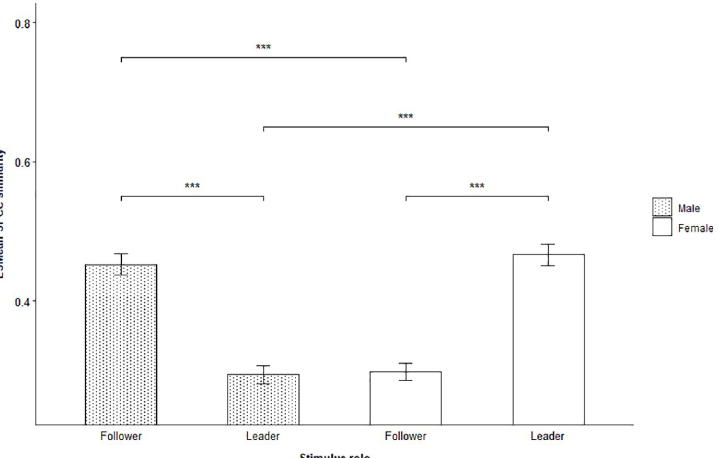
Fig 7. Effect of vocal role and sex on stimulus-response similarity. LSMean ( ± SE) spectrographic cross-correlation (SPCC) similarity between stimulus calls and focal flock responses emitted during the interaction phase of male-female trials. The figure shows the difference between leaders and followers of both sexes. Significant selected pairwise comparisons are indicated with asterisks.